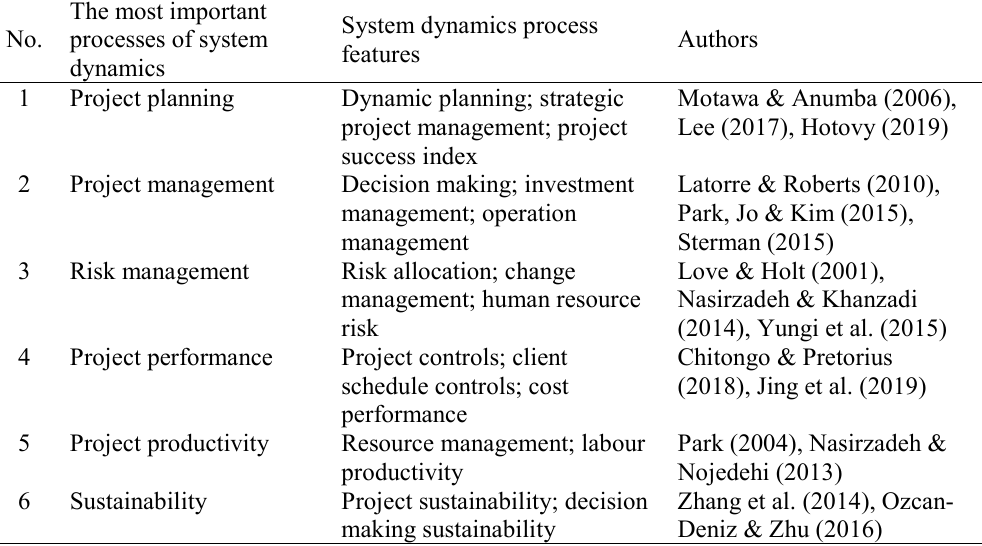
Table 2. The Most Important System Dynamics Processes at the